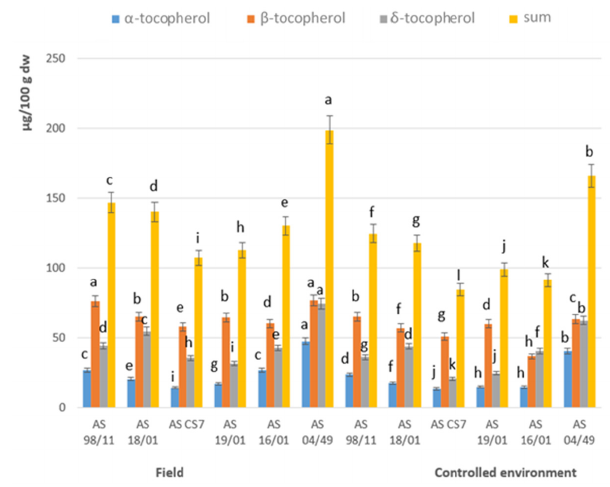
Figure 4. Content of tocopherols of the studied Agaricus subrufescens samples produced in the field and in controlled en-vironment crops. Mean values ( n = 3); identical superscripts (a–l) denote no significant ( p < 0.05) difference between mean values in columns according to Tukey’s HSD test (ANOVA) for mushrooms produced in the field and in controlled environment crops.